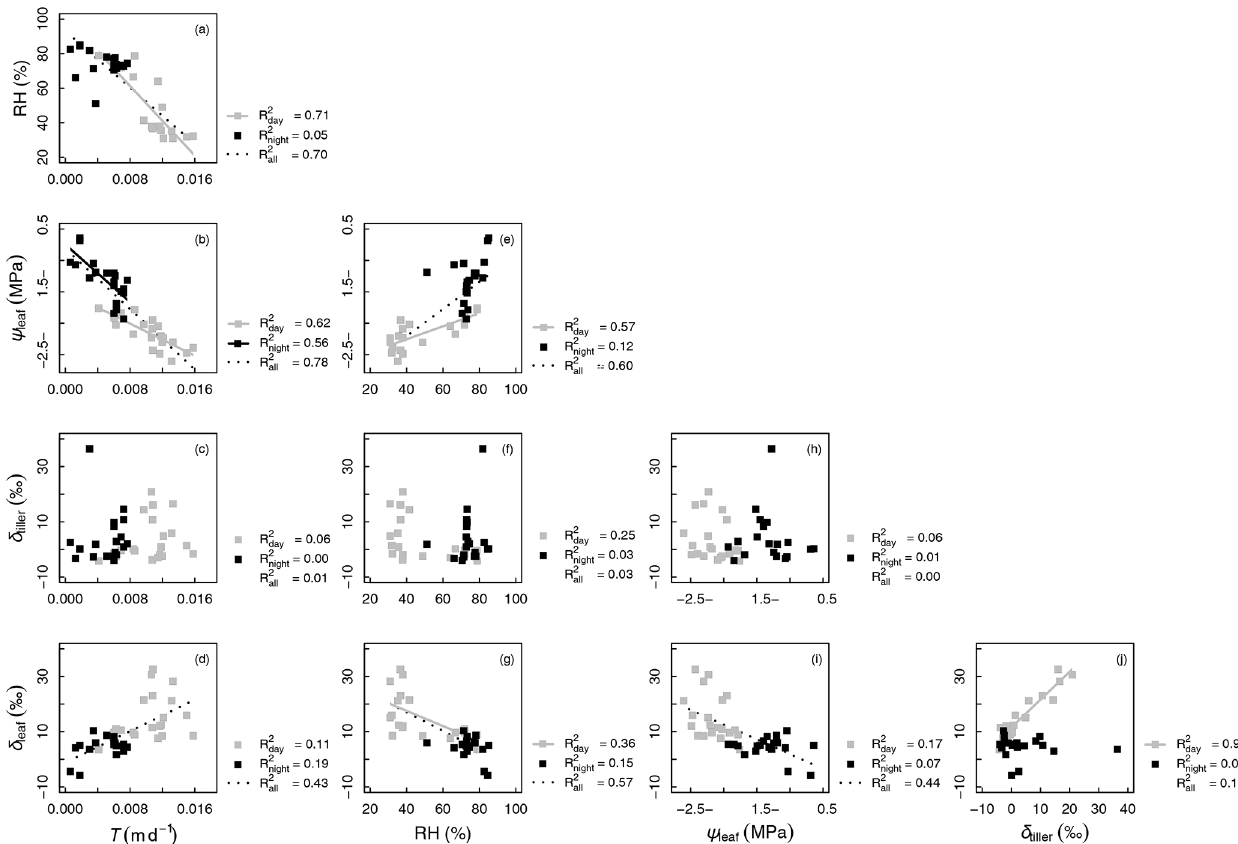
Figure 4. Correlations between measured variables: oxygen isotopic compositions of xylem and leaf waters ( δ tiller and δ leaf , respectively, in ‰), transpiration rate ( T , in md − 1 ), relative humidity (RH, %), and leaf water potential ( ψ leaf , in MPa). The coefficients of determination ( R 2 values) are reported for all data as well as separately for “day” (gray symbols) and “night” data (black symbols; see Appendix C for definition of “day” and “night” experimental periods). Regression lines are drawn for linear models with a p